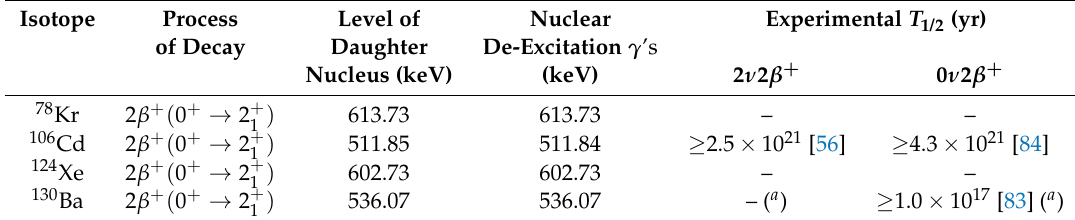
Table 5. All the isotopes where the 2 β + decay (2 ν and 0 ν ) to the excited levels of daughter nuclei is allowed. When available, the present best experimental result on T 1/2 (limits are at 90% C.L.) is reported. Only transitions to the first 2 + excited level of the daughter nucleus are allowed. See text.